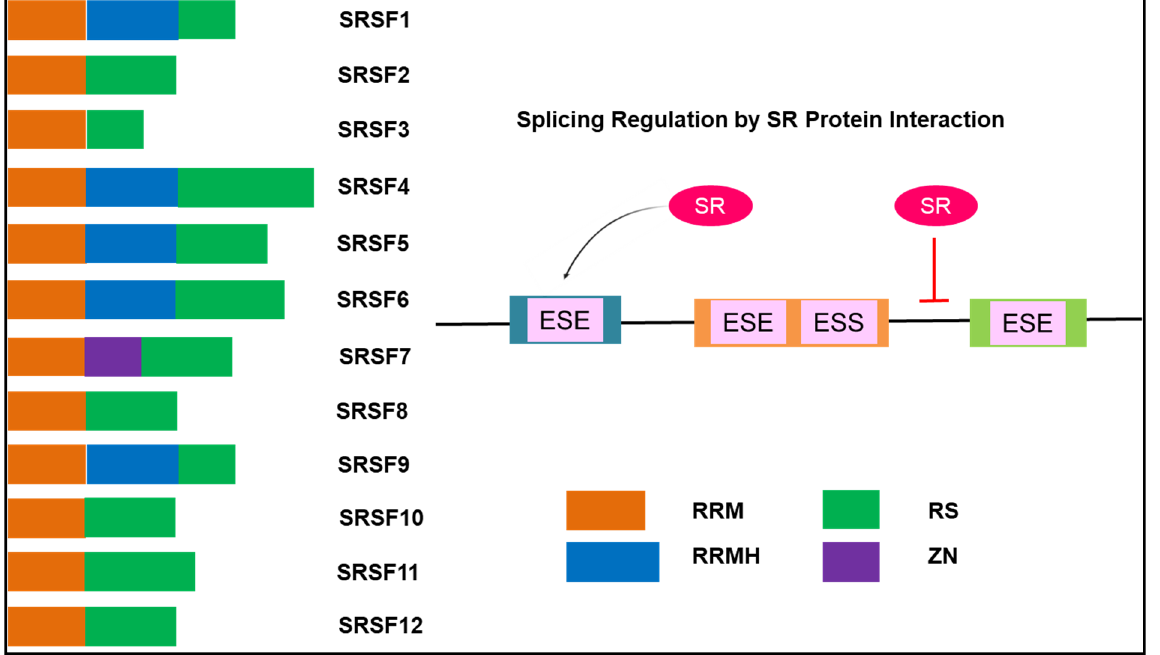
Figure 3. Alternative splicing regulation by SR binding. The domain structure of the 12 serine-rich (SR) proteins indicating the RRM (RNA recognition motif), RRMH (RRM homology), RS (arginine/serine-rich domain), and Zn (Zink knuckle). SR proteins bind to exonic splicing enhancers (ESEs), facilitating splice site recognition and stimulating the activation of splicing. In comparison, splicing is inhibited by the binding of the SR to introns [64–66].